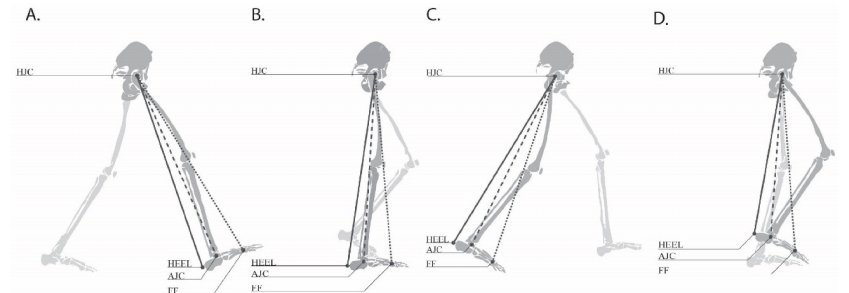
Figure 1. DLLs during the gait cycle phases measured from hip joint center (HJC) to the heel marker (HEEL), to the ankle joint center (AJC) and to the forefoot marker (FF) (( A ) initial contact, ( B ) mid stance, ( C ) pre-swing, ( D ) mid swing).